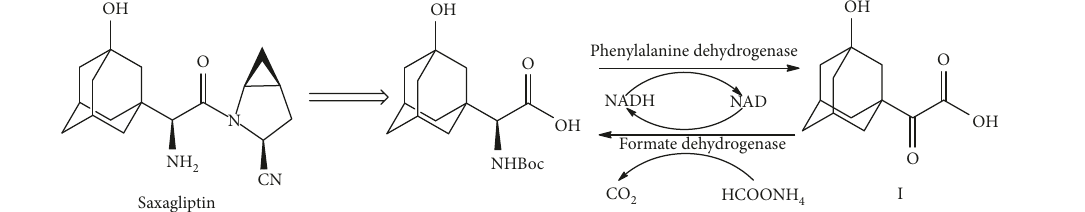
Figure 1: Retrosynthesis analysis of Saxagliptin.